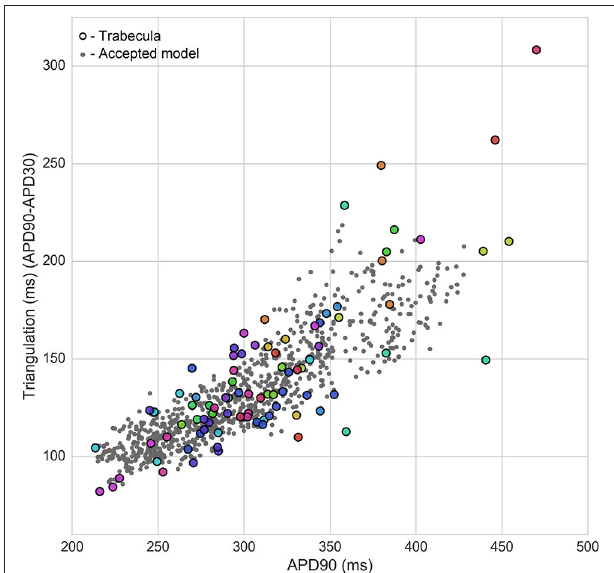
FIGURE 4 | Calibration of heart-specific populations of models using biomarker ranges. Values from all individual trabeculae (colored dots–each color corresponds to a donor heart), and for all models accepted into any population (gray dots) are shown for APD90 vs. triangulation, two of the five biomarkers used to construct the populations, which are also biomarkers of drug-induced pro-arrhythmic